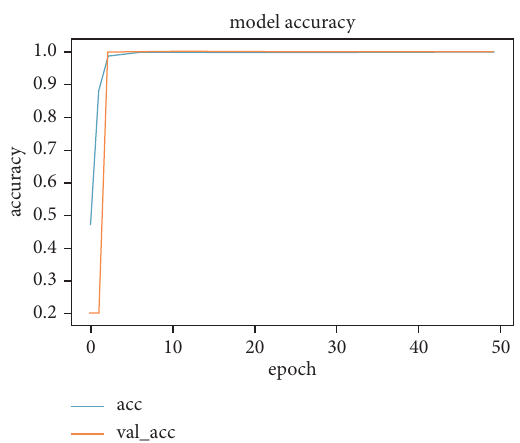
Figure 19: The accuracy rate of action idea EEG in static state during model